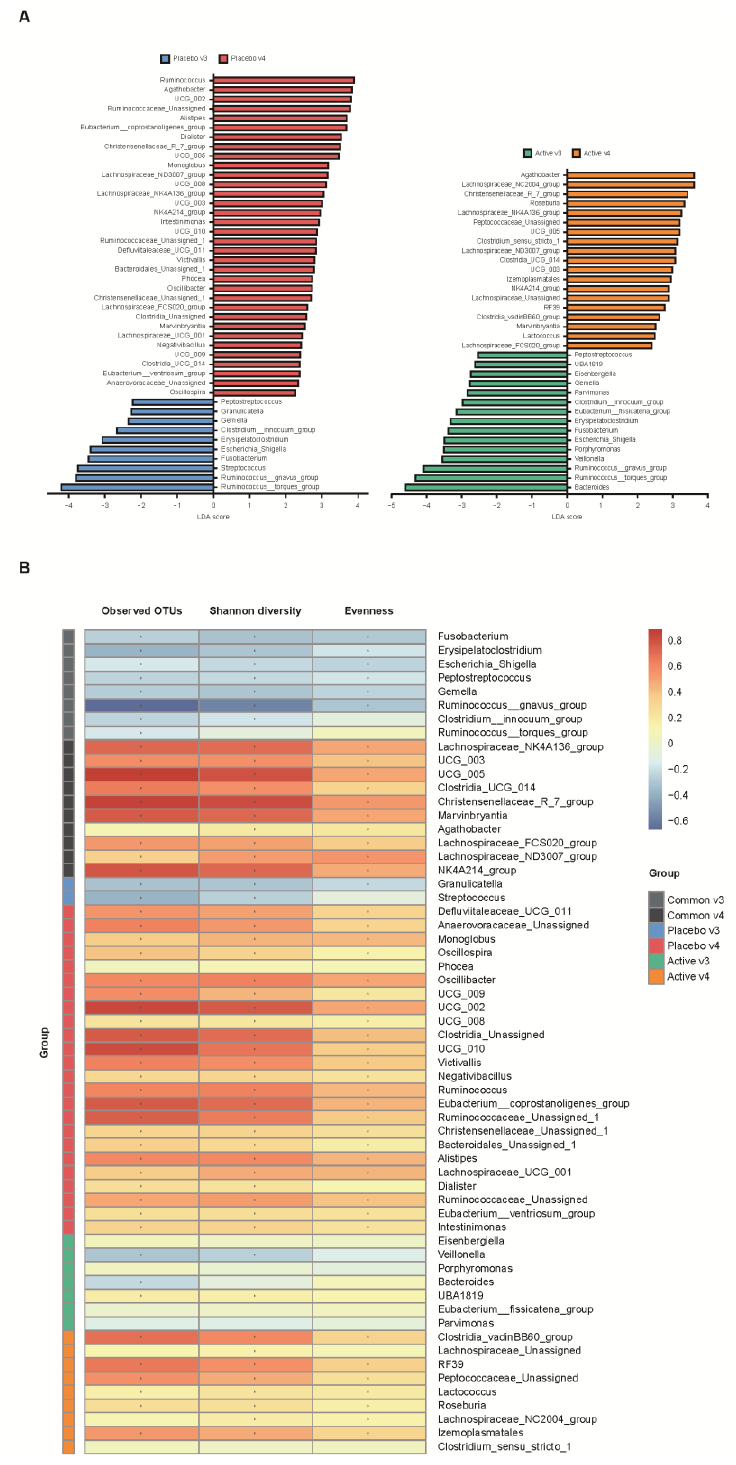
Figure 6. Comparative analysis of the 3rd and 4th visit groups. ( A ) Microbiome analysis via linear discriminant analysis (LDA) effect size (LefSe) at the genus level. The bar size represents the effect of specific taxa number in the particular group at the genus level. The alpha value for the factorial Kruskal–Wallis test was <0.05 and the threshold on the logarithmic LDA score for discriminative feature was >2.0. ( B ) Heatmaps indicate positive (red) and negative (blue) correlations between the alpha diversity and the taxa sorting in the results of LEfSe. The figure was drawn by sorting the taxa based on the result in ( A ). * p < 0.05 (Spearman’s correlation).